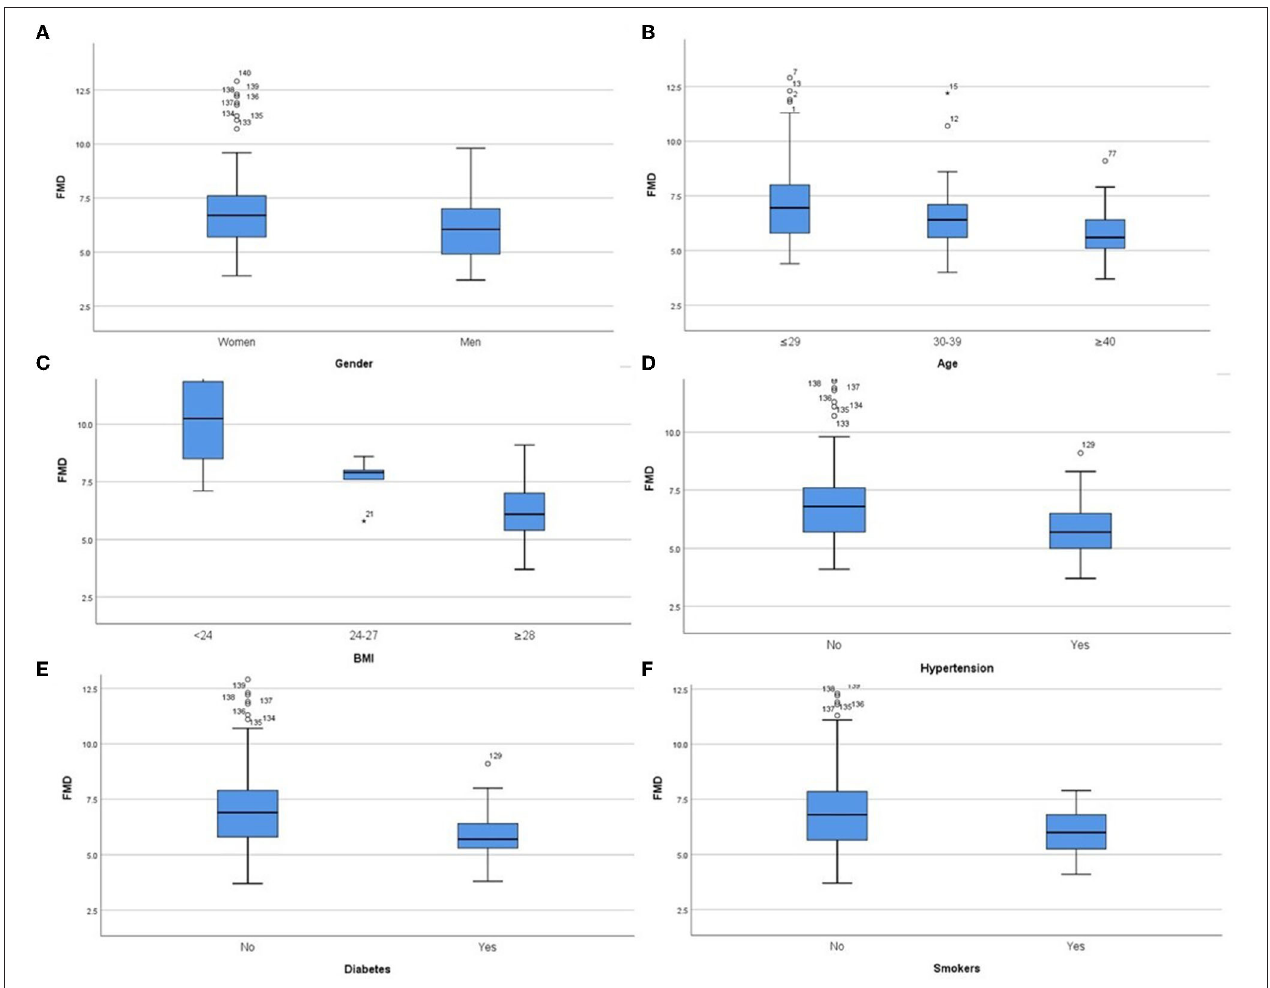
FIGURE 1 | Comparison of FMD values in subgroups of both genders (A) , different ages (B) , different BMIs (C) , hypertension (D) , diabetes (E) and smoking (F) . P < 0.05 in all subgroups.